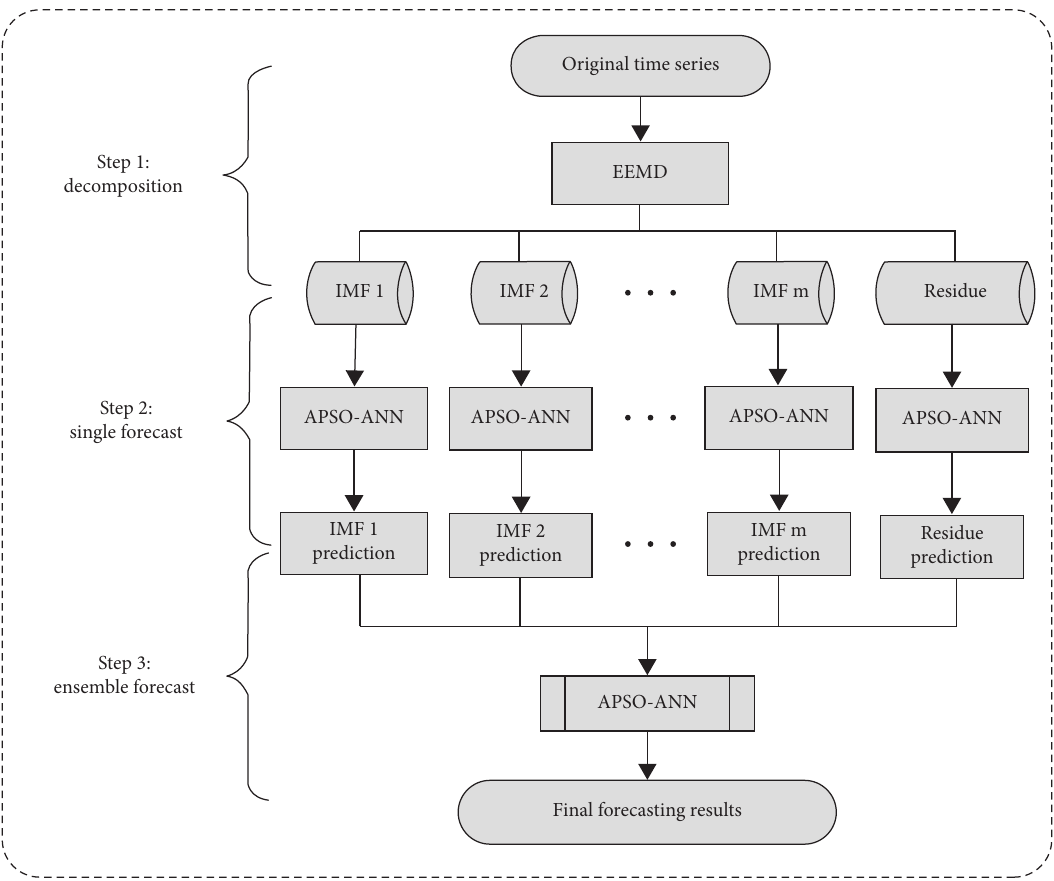
Figure 2: The general framework of our proposed decomposition ensemble